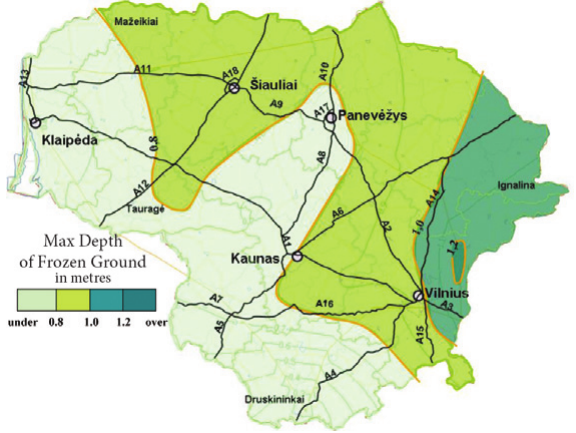
Fig. 6. Distribution of the max depth of frozen ground in the territory of Lithuania based on RWIS data (Juknevičiūtė- Žilinskienė